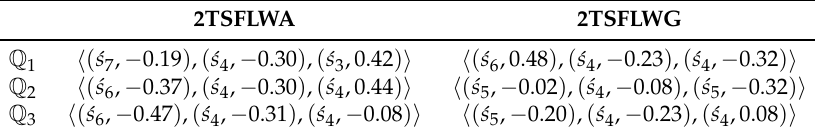
Table 2. The aggregated values of alternative by the 2TSFLWA (2TSFLWG) operators.